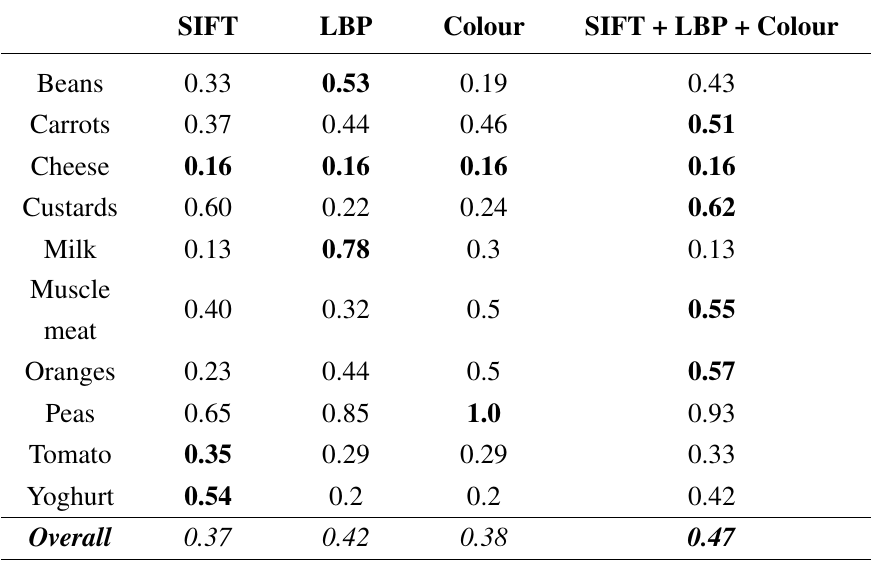
Table 3. Recognition accuracy of the food image recognition method with various feature types. SIFT, scale invariant feature transformation; LBP, local binary